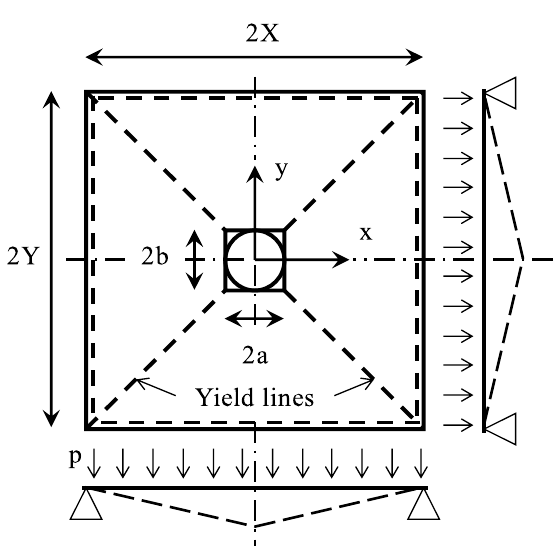
Figure 2. Mode shape of rigid-plastic plate with yield lines adopted for plate geometry having rectangular holes with or without circular